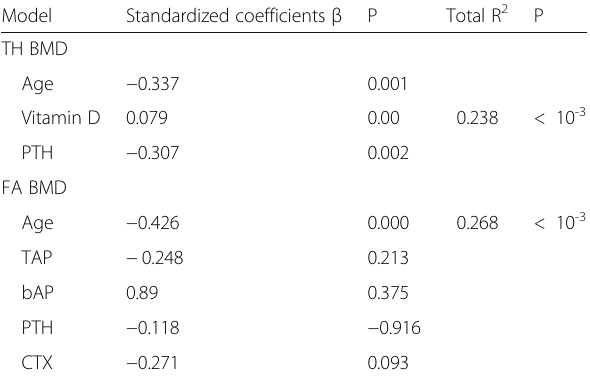
Table 6 Predicting models of total hip BMD and total body BMD Model